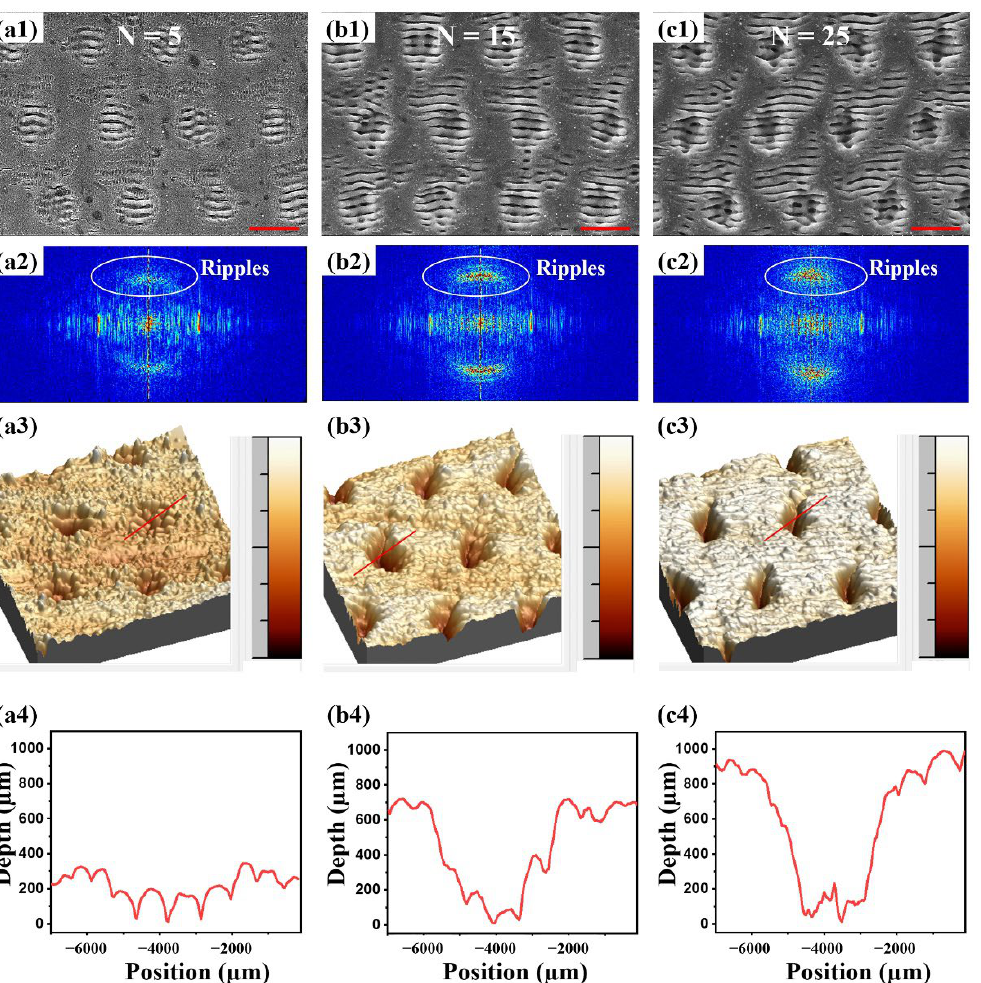
Figure 2. Surface morphologies of NiTi alloy under the action of burst Bessel beam with low N and Fourier transformation of SEM LIPSS–pit structure. ( a1 – c1 ) Surface morphologies of NiTi alloy under the action of burst Bessel beam with ( a1 ) N = 5, ( b1 ) N = 15, and ( c1 ) N = 25. ( a2 – c2 ) 2D Fourier transformation of the SEM LIPSS–pit structure in ( a1 – c1 ). ( a3 – c3 ) 3D AFM of SEM LIPSS–pit structure in ( a1 – c1 ). ( a4 – c4 ) 2D AFM of single LIPSS–pit structure in ( a1 – c1 ). (Scale bar = 5 µ